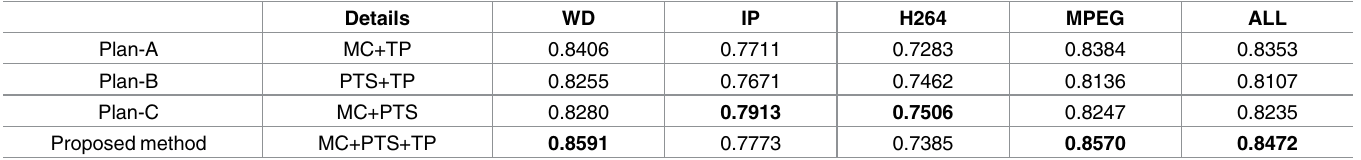
Table 2. PLCC comparison for each module of the proposed VQA